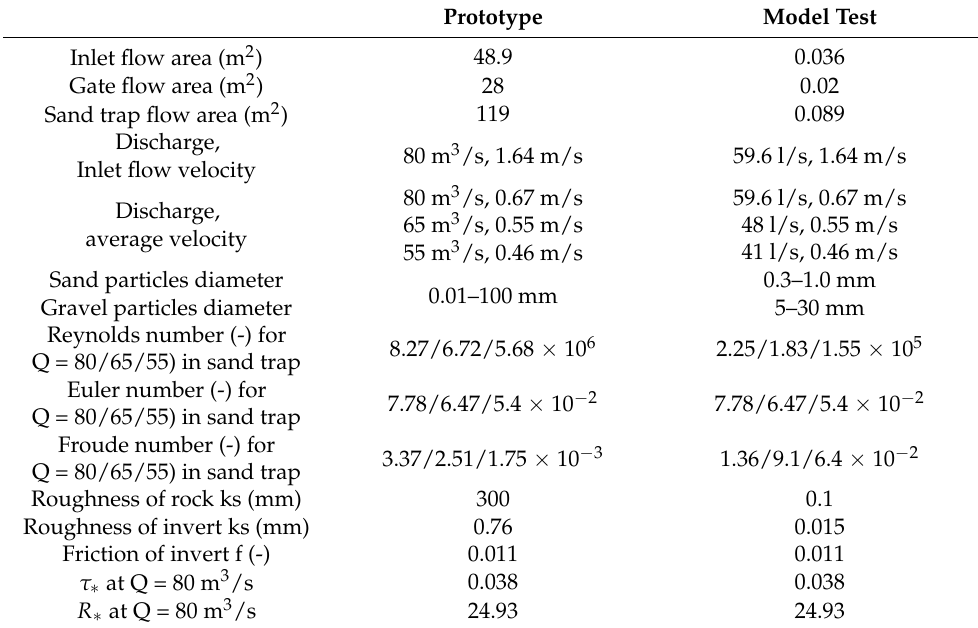
Table 3. Model test